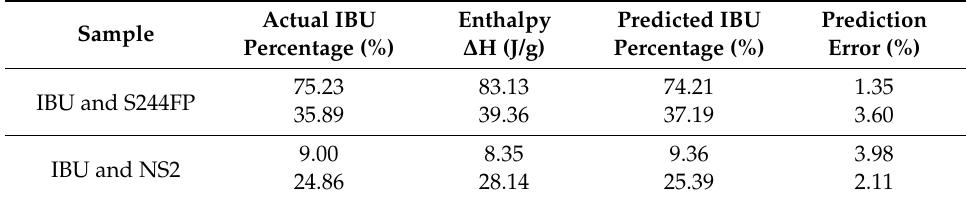
Table 2. Comparison of the predicted and actual